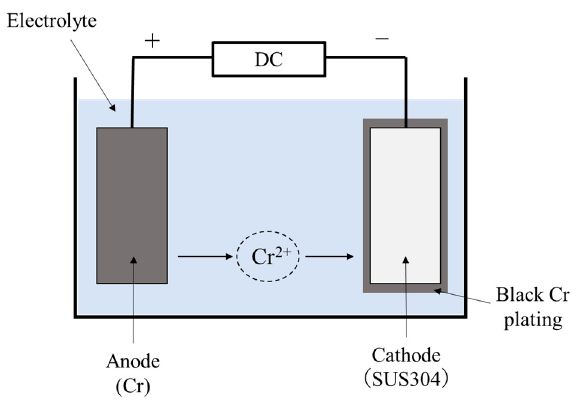
Figure 1. Schematic diagram of the black chrome (Black Cr) plating.